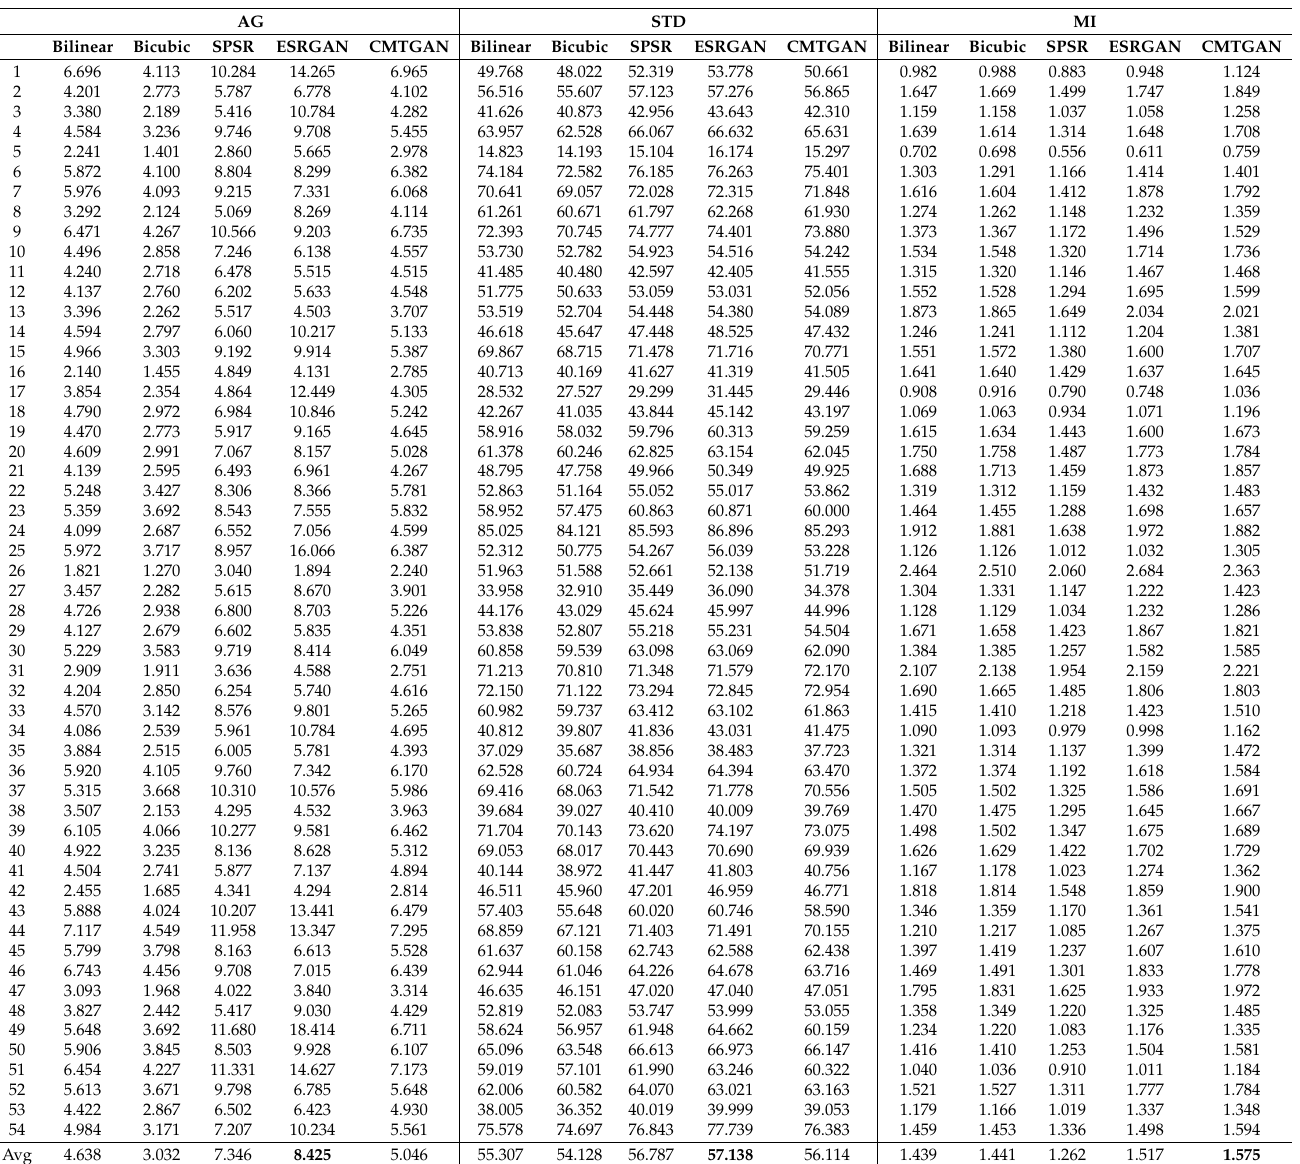
Table 4. Metrics of super-resolution.